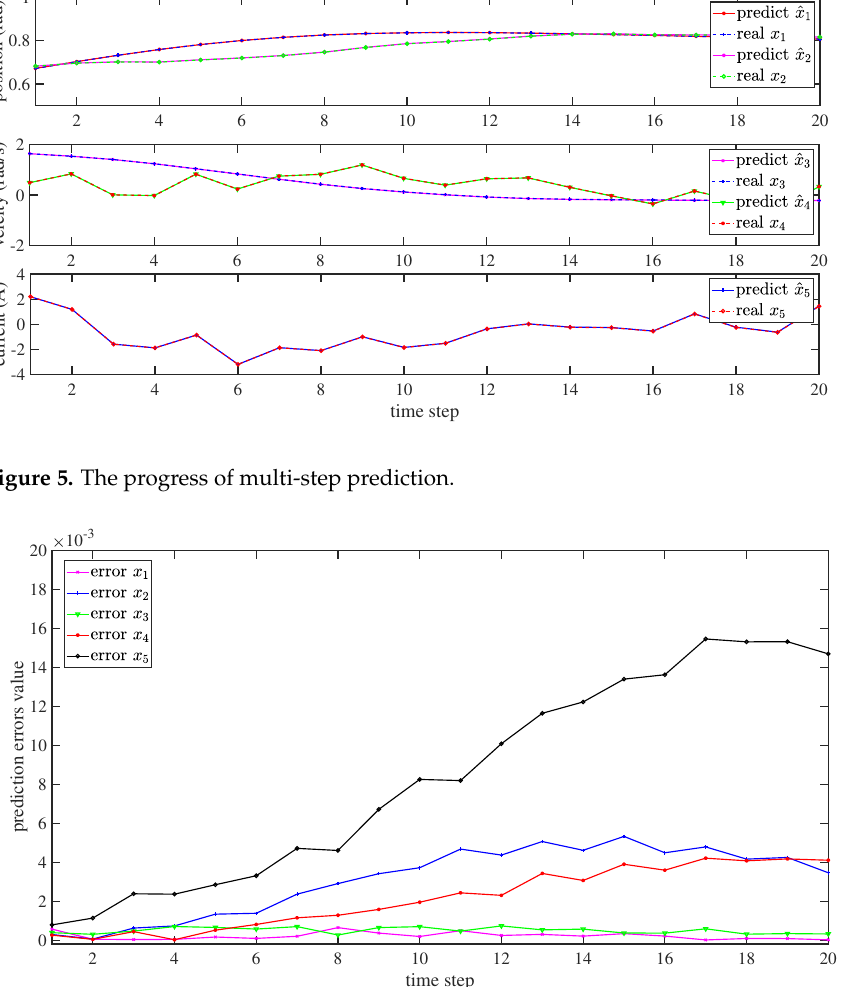
Figure 6. The absolute errors of multi-step prediction. In the simulation procedure, the time step for the suggested method and DDP MPC was 20 ms, and the prediction horizon was five time steps. The parameters of the DEO algorithm are displayed as follows, F 0 = 0.5, CR = 0.5, NP = 30, G m = 200. The control inputs were constrained in [ − 24 V, 24 V ]